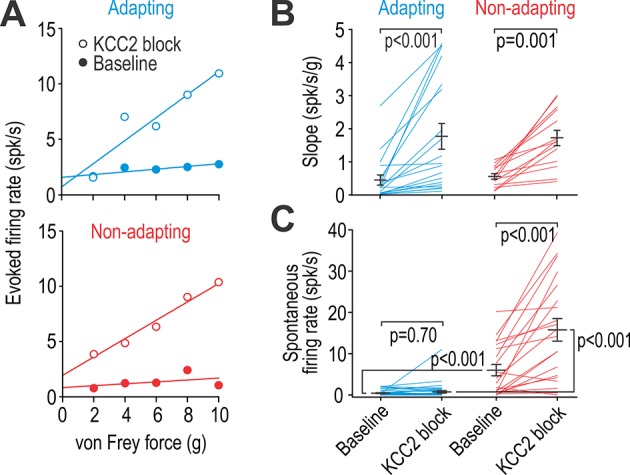
Adapting and non-adapting units are differentially affected by KCC2 blockade.(A) Input-output (i–o) curves show firing rate evoked by increasing force applied by von Frey hairs to the RF surround in a typical adapting unit (blue) and non-adapting unit (red) before and after blockade of KCC2. (B) KCC2 blockade had a significant effect on slope (F1,31 = 35.68, p<0.001; two-way repeated measures ANOVA). That effect did not differ between cell types (interaction, F1,31 = 0.15, p=0.71) although the largest increases were observed in adapting units. Results of Wilcoxon tests are reported on graphs. (C) KCC2 blockade also had a significant effect on spontaneous firing (F1,57 = 58.60, p<0.001; two-way repeated measures ANOVA) but that effect differed between cell types (F1,57 = 33.79, p<0.001): non-adapting units experienced a significant increase in spontaneous firing (Z19 = 3.58, p<0.001; Wilcoxon test) whereas adapting units did not (Z38 = 0.39, p=0.70). Spontaneous firing differed significantly between cell types at baseline (U58 = 116.5, p<0.001; Mann-Whitney test) and after KCC2 blockade (U58 = 55.5, p<0.001). See also Figure 4—figure supplement 1 for the effect of glycine receptor blockade on spontaneous firing.Figure 4—source data 1.Numerical values for data plotted in Figure 4.